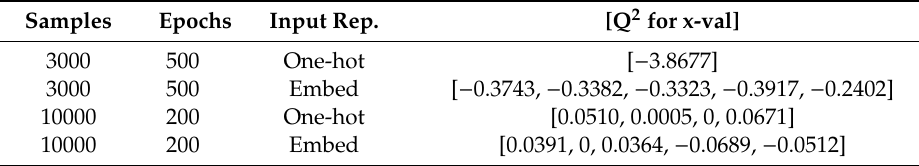
Table 1. Q 2 values for various models with log IC 50 output.